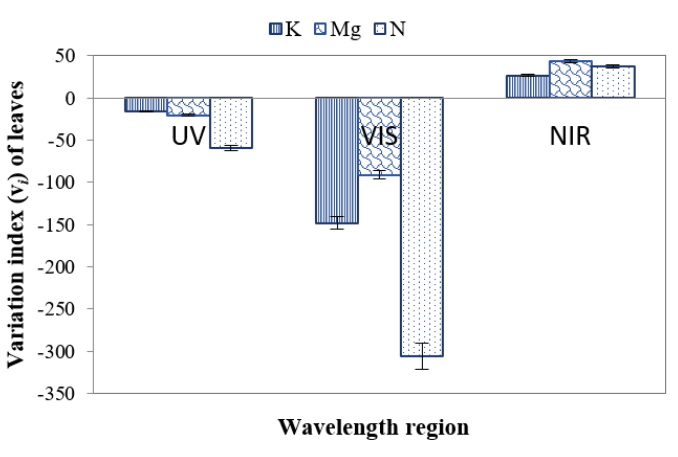
Figure 13. Variation index (v i ) of leaves in the U.V., VIS and N.I.R. regions for distinguishing control and different nutrient-deficient